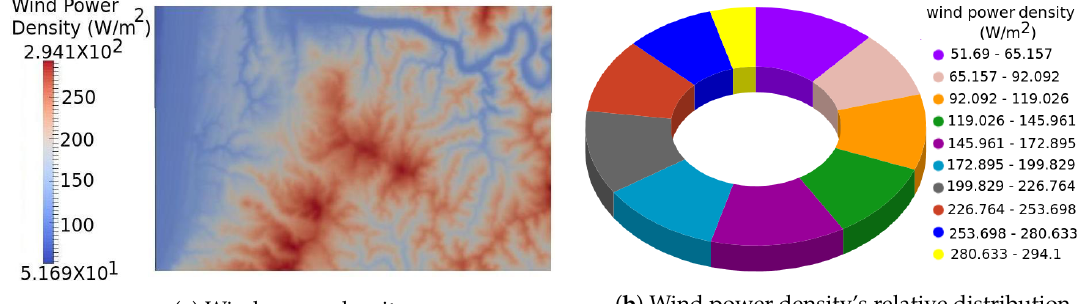
Figure 13. Wind power density at 30